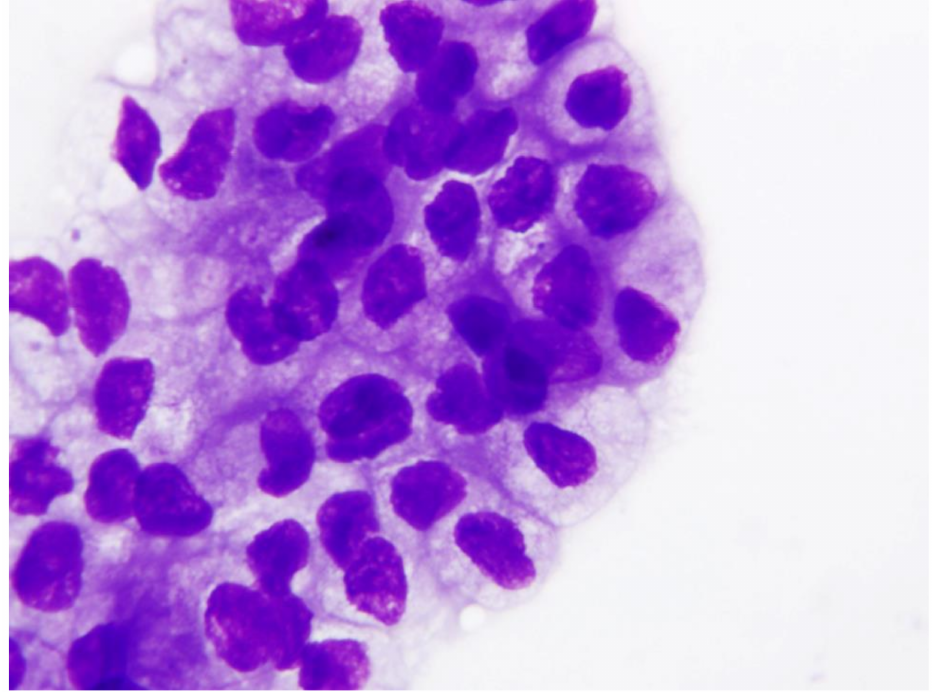
Figure 5. Cell group from a specimen categorized as suspicious for malignancy. Individ- ual cells demonstrate nuclear enlargement with some nuclear crowding is not marked, the nu- clear/cytoplasmic ratio remains below 0.6 and there is only moderate anisonucleosis. This material is best classified as suspicious for malignancy (Diff–Quik